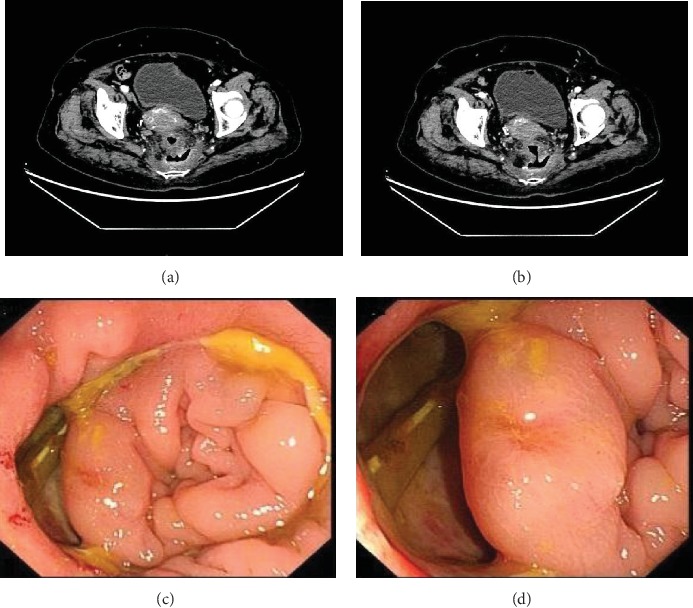
Images of anastomotic leakage. (a) Pelvic contrast-enhanced computed tomography picture showing pneumatosis and hydrops around the anastomosis; (b) pelvic contrast-enhanced computed tomography picture showing the communication between the lumen of the bowel and pelvic cavity; (c) endoscopic picture showing the defect of anastomosis; (d) endoscopic picture showing that the pelvic drainage tube can be seen from the anastomotic defect.